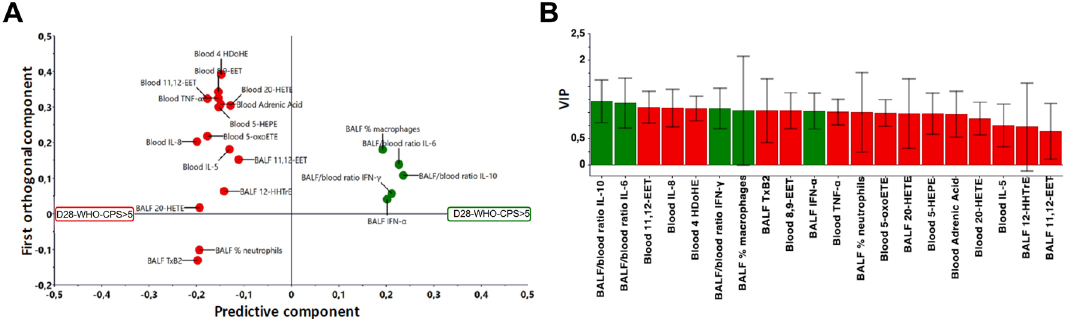
Figure 4. Supervised orthogonal partial least squares discriminant analysis (OPLS-DA) obtained from critically ill COVID-19 patients, according to 28-day WHO-CPS. Patients were grouped according to the World Health Organization 10-point Clinical Progression Scale (WHO-CPS) at 28-day. A score value higher than 5 (D28-WHO-CPS > 5) defined a poor 28-day outcome, whereas a score value equal or lower than 5 (D28-WHO-CPS ≤ 5) defined a good 28-day outcome. ( A ) Loading plots summarize the relationship of the 20 most discriminating variables labeled according to their association to D28-WHO-CPS ≤ 5 (green dots) and D28-WHO-CPS > 5 (red dots). ( B ) VIP (Variable Influence on Projection) plots summarize the importance of the 20 most discriminating variables. Histogram is colored according to the variable associations to D28-WHO- CPS ≤ 5 (green bars) and D28-WHO-CPS > 5 (red bars). BALF bronchoalveolar lavage